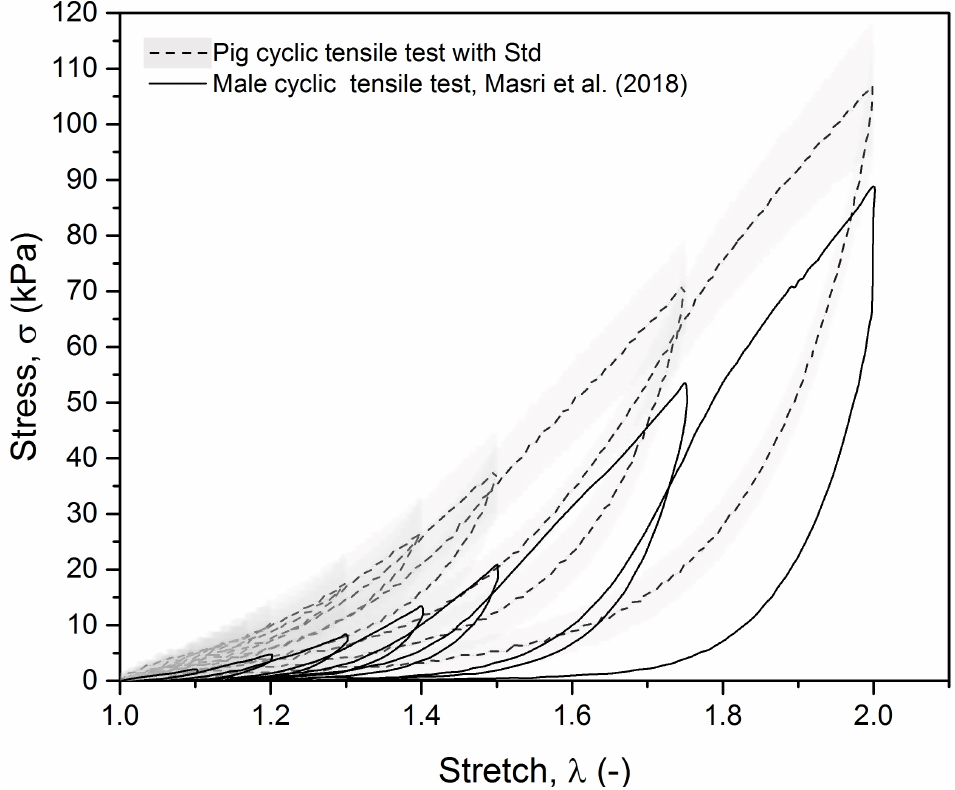
Figure 8. Comparison of the experimental results of longitudinal samples of the urethra from male pig and male human subjects (grey ribbon—STD of the results of the current